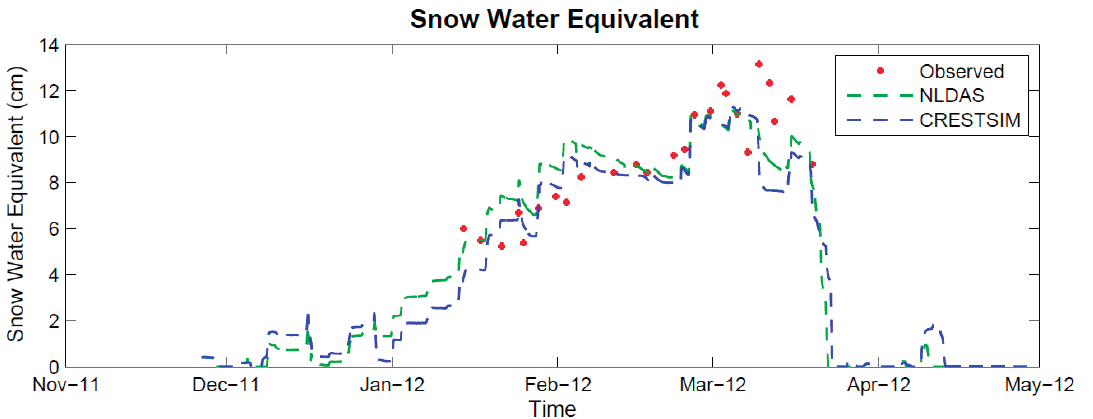
Figure 6. Time series for 2011–2012 winter. Snow water equivalent (cm). Legend: manual CREST-SAFE Observations (Observed), NLDAS meteorological data simulation (NLDAS), and CREST-SAFE meteorological data simulation (CRESTSIM).